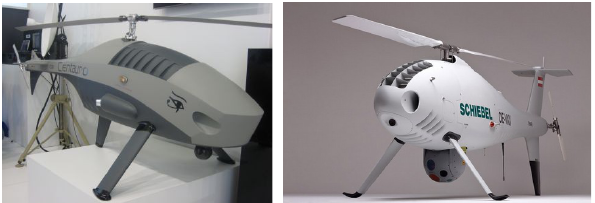
Figura 5. Examples of unmanned aerial systems based on combustion engines.